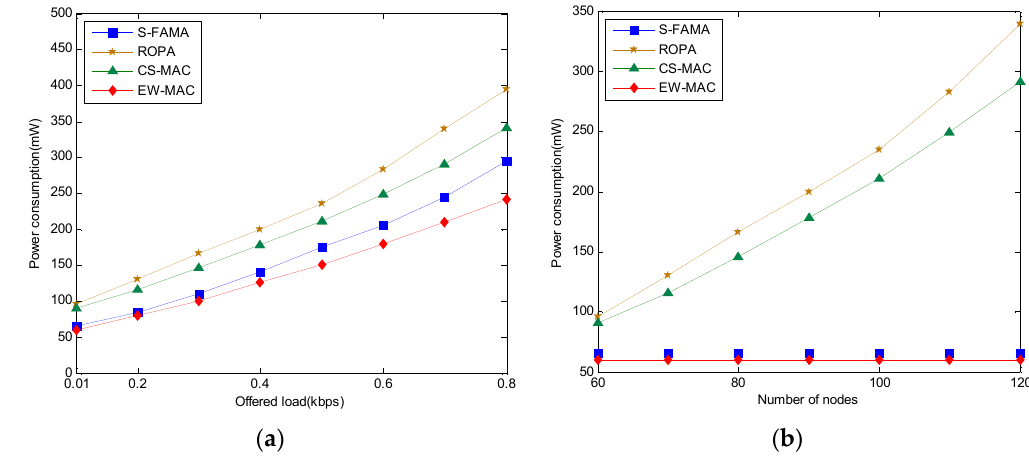
Figure 9. Power consumption. ( a ) The protocols consume energy according to the offered load within range (0.1, 0.8) k bytes in each second among 80 sensors; ( b ) The protocols consume energy according to the number of sensors within range (60, 100) while offered load is 0.3 kbps.